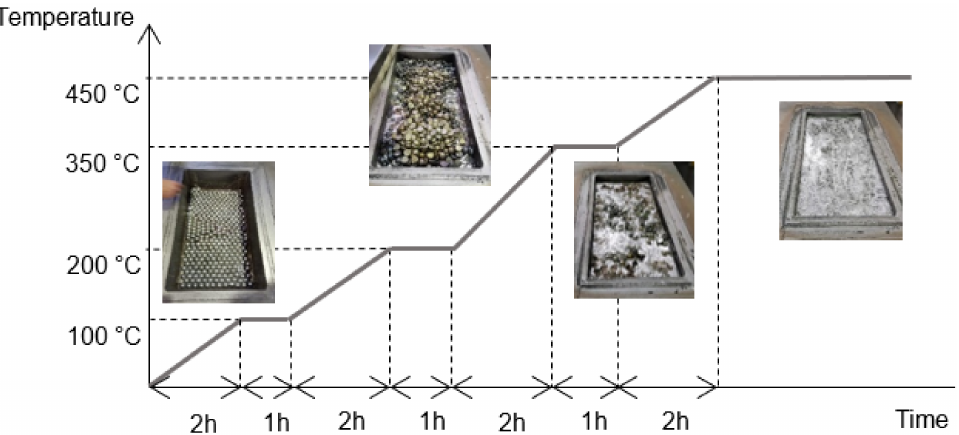
Figure 2. Time-temperature profile of the melting process to produce a standard batch galvanising zinc